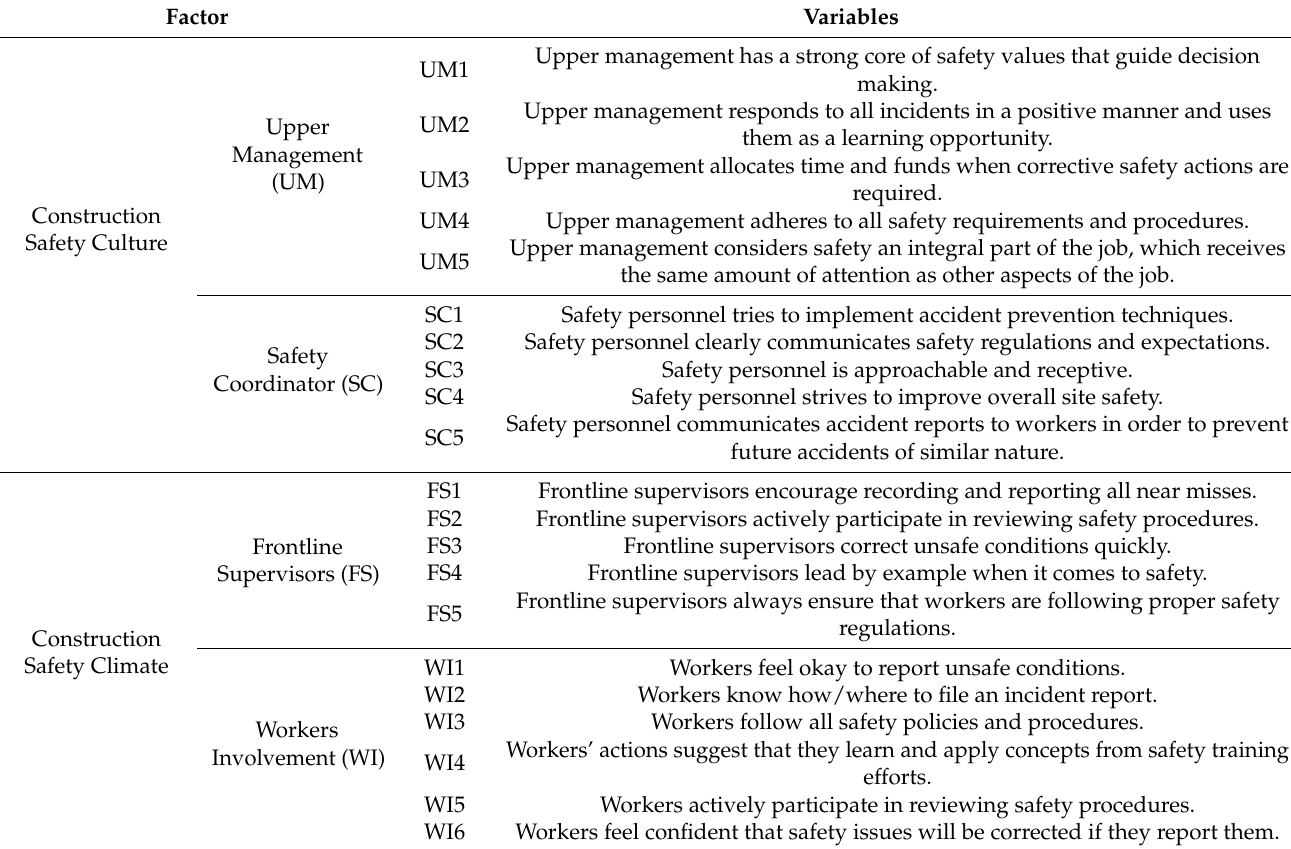
Table A1. Construction Safety Culture and Safety Climate Measurement.